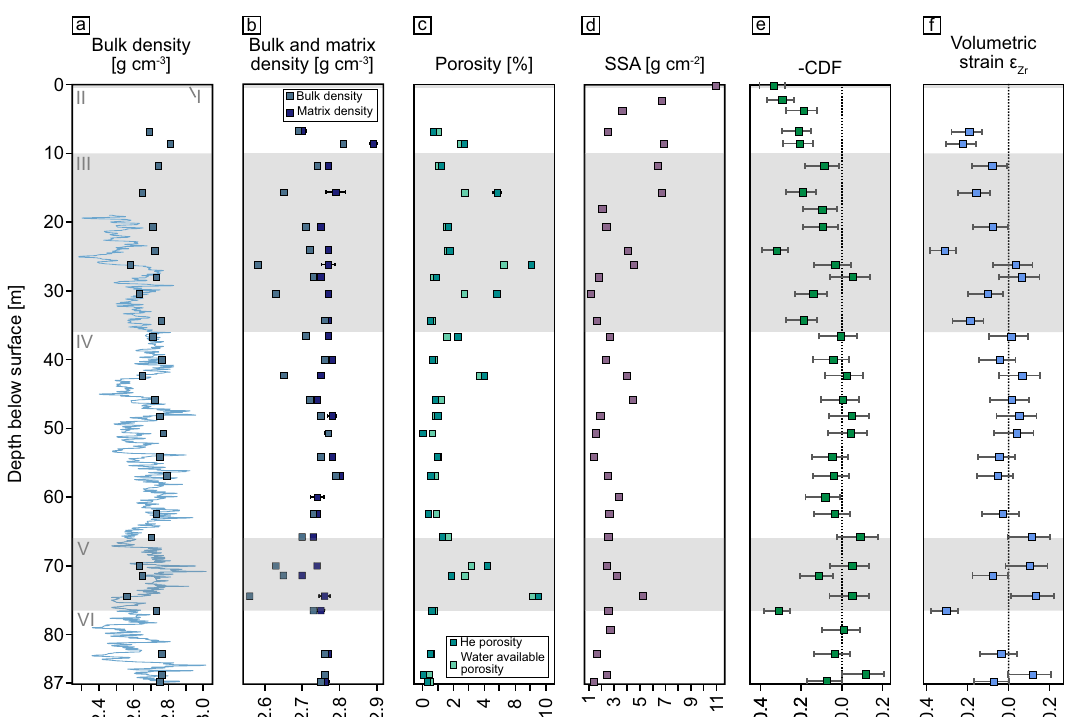
Figure 5. ( a ) Measured bulk density (dark blue) and calculated bulk density from p-wave velocities (light blue). ( b ) Matrix density indicates the rock density without pores; bulk density the density including pore volume. Error bars indicate the standard deviation of 10 replicate measurements of the same sample. ( c ) Porosity measured with He pycnometry (“He Porosity”) and water saturation (“Water available porosity”). ( d ) Specific surface area (SSA) of powdered samples measured by N 2 sorption analysis using the BET equation. ( e ) Chemical depletion fraction (CDF) shows fractional mass loss relative to the average of four bedrock samples (negative CDF). Dotted reference line for zero mass loss. Values > 0 indicate elemental loss. ( f ) Calculated volumetric strain (ε Zr ) for the weathering profile. Positive values indicate dilation whereas negative values denote the collapse of the profile. The accuracy of the CDF and of ε Zr is limited by the variability in bedrock Zr concentration which is shown as error bars on all samples in panel ( e ) and ( f ). Grey and white shades denote the core zones (I–VI) described in the